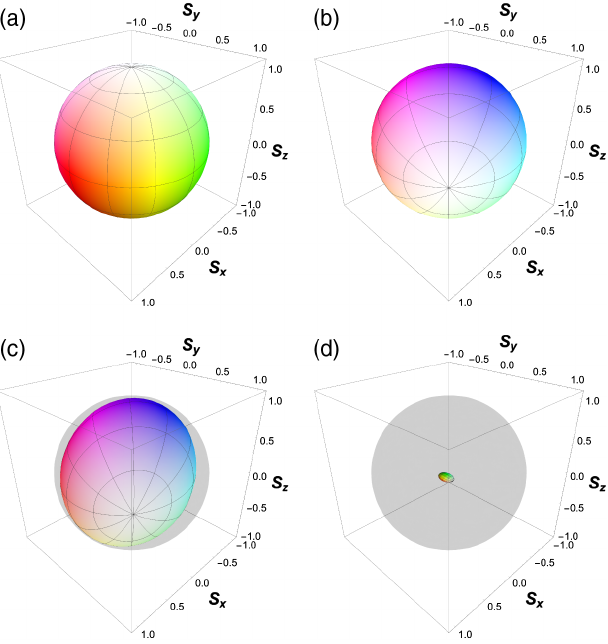
FIG. 11. Background compensated version of Fig. 10.